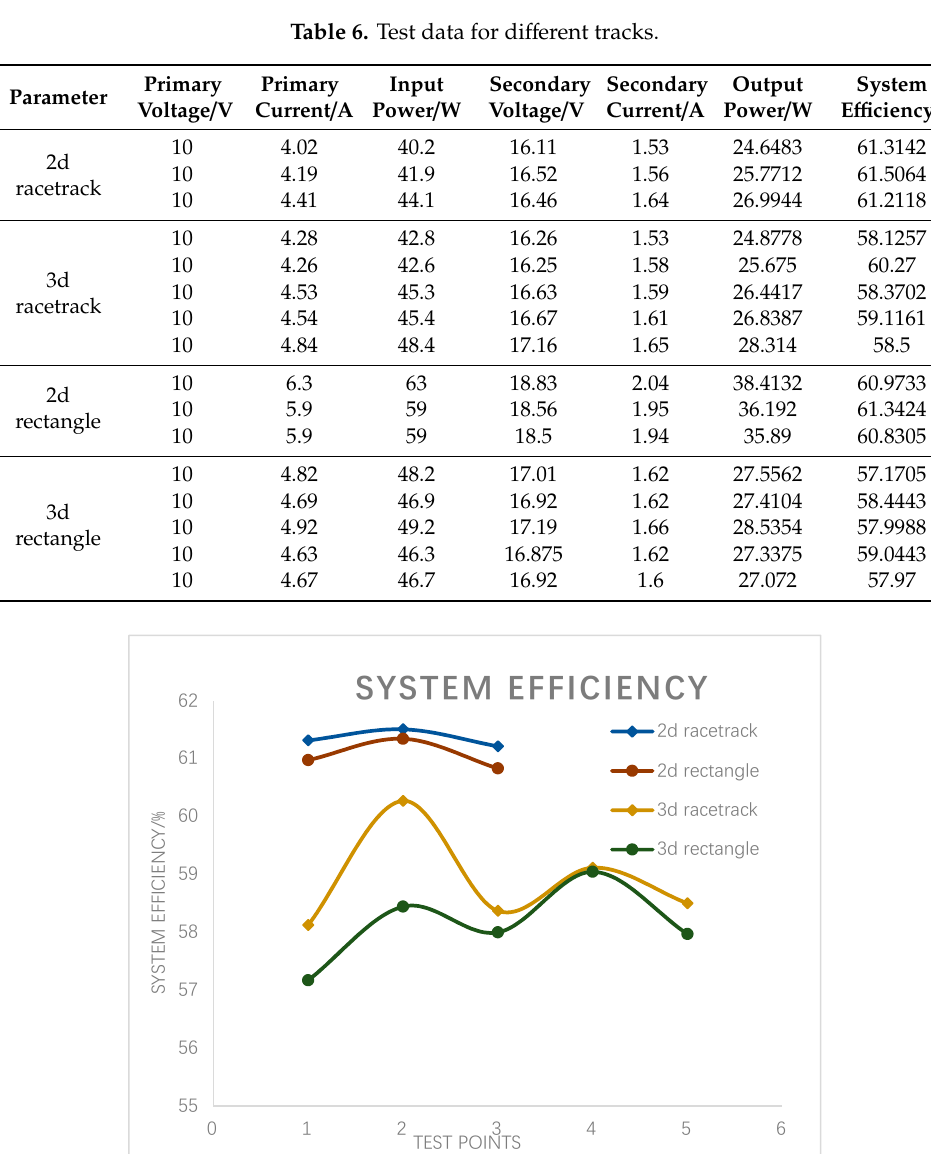
Figure 11. System efficiency of different tracks. Figure 11. System e ffi ciency of di ff erent